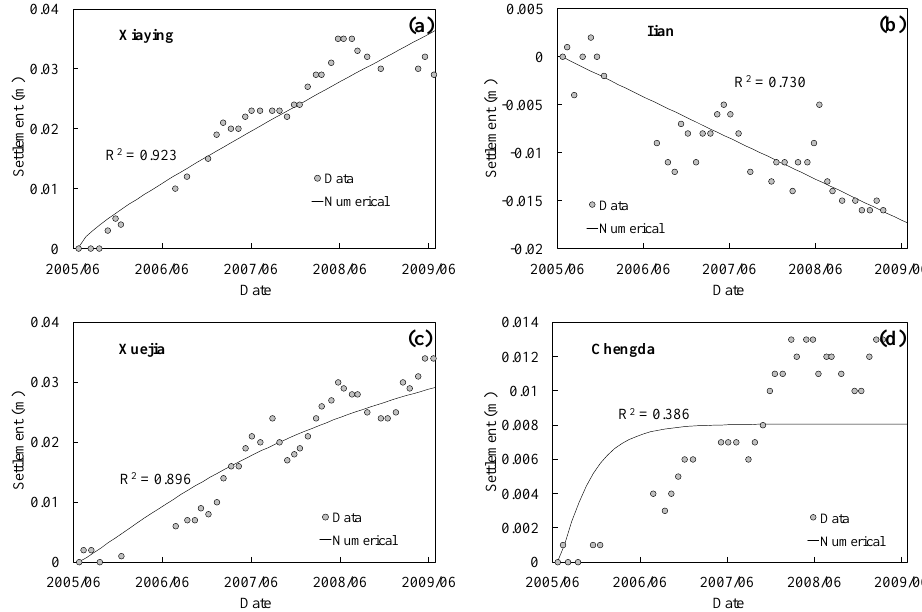
Figure 4. Fitting results for (a) Xiaying, (b) Iian, (c) Xuejia, and (d) Chengda MCMWs obtained using the NPM (From Wang et al., 2015).